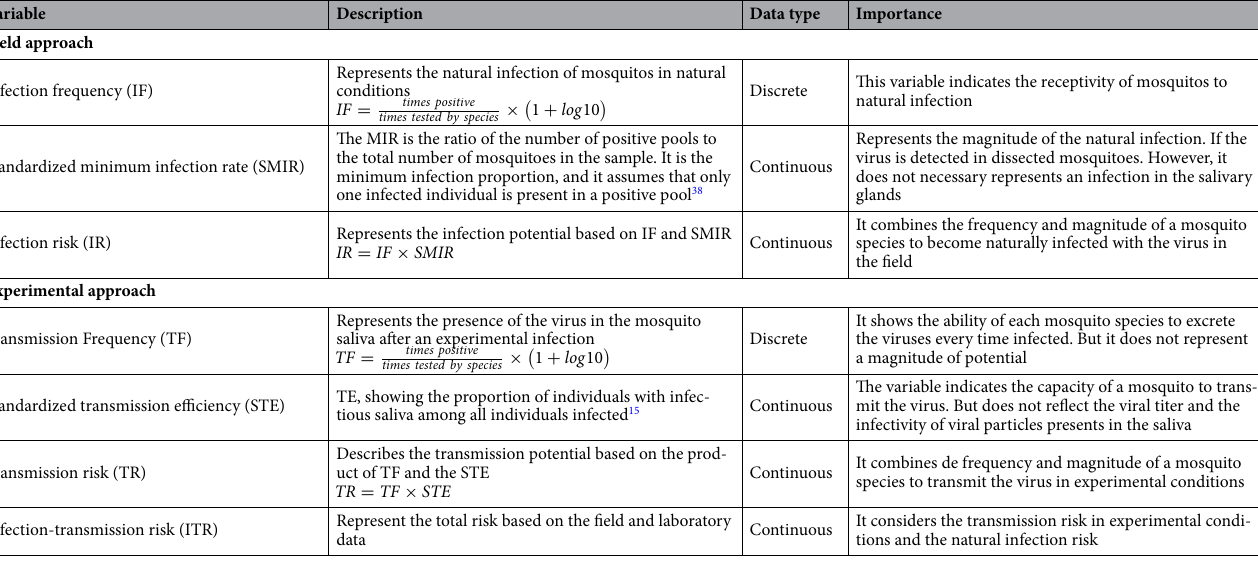
Table 1. Description of the